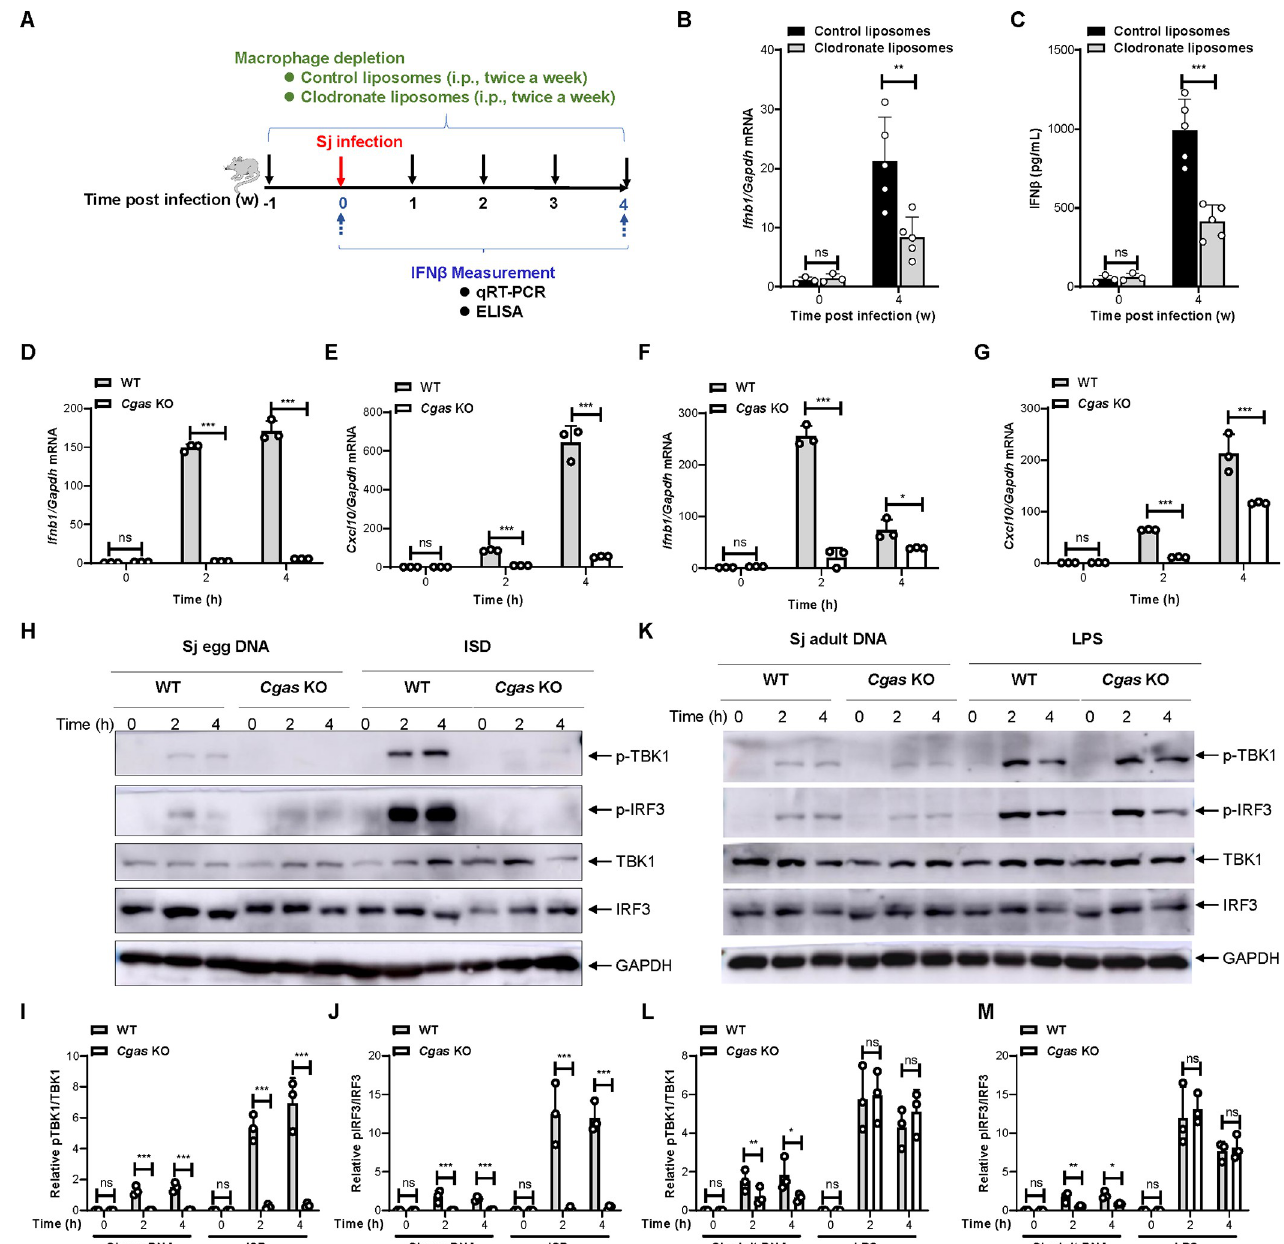
Fig 6. Sensing of schistosome-derived DNA by cGAS in macrophages mediates type I IFN response to S . japonicum infection. (A) Scheme for the clodronate liposome-mediated depletion of macrophages in mice and detection of interferon beta in the liver and sera of mice infected with S . japonicum . Mice were treated with control liposomes or clodronate liposomes twice a week for 1 week before infection and administered continuously for 4 weeks post infection at an interval of twice a week. The liver tissue and sera were collected from mice left uninfected or infected with S . japonicum for 4 weeks for further detection of interferon beta. (B) qRT-PCR measurement of Ifnb1 transcripts in the liver tissues of mice infected with S . japonicum for the indicated times treated with control or clodronate liposomes. (C) ELISA detection of IFN β in serum harvested from mice infected with S . japonicum for the indicated times treated with control or clodronate liposomes. (D-E) qRT-PCR measurement of transcripts of Ifnb1 and Cxcl10 in wild-type and Cgas knockout peritoneal macrophages transfected with DNA from egg of S . japonicum for the indicated times. (F-G) qRT-PCR measurement of the transcripts of Ifnb1 and Cxcl10 in wild-type and Cgas knockout peritoneal macrophages transfected with DNA from adult schistosomes for the indicated times. (H-J) Western blotting detection of the indicated proteins in the lysates of mouse peritoneal macrophages isolated from wild-type and Cgas KO mice stimulated with S . japonicum egg DNA and ISD for the indicated times (H). The quantification data is shown in (I and J). (K-M) Western blotting detection of the indicated proteins in the lysates of mouse peritoneal macrophages isolated from wild-type and Cgas KO mice stimulated with adult S . japonicum DNA and LPS for the indicated times (K). The quantification data is shown in (L and M). Two-way ANOVA with Bonferroni’s post hoc test were used for the statistical analysis in (D-G). ns, not significant; � , p < 0.05, �� , p < 0.01, ��� , p < 0.001.